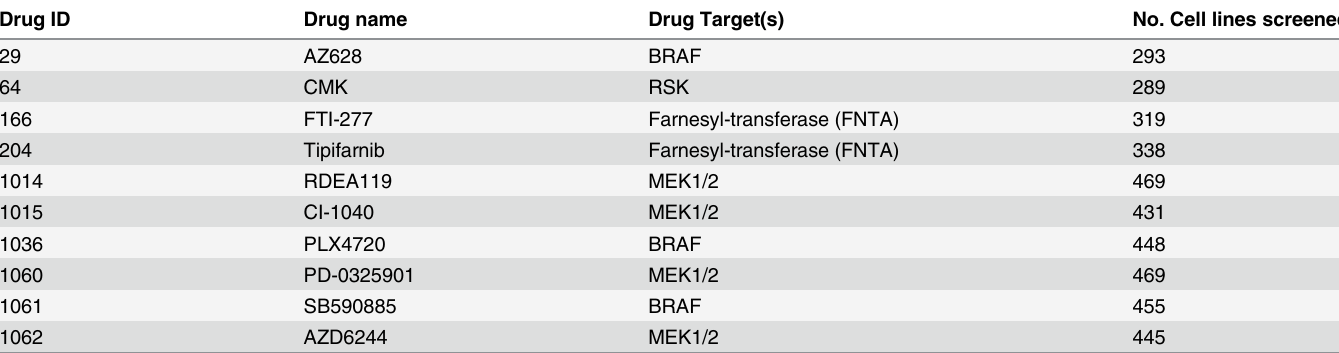
Table 2. 10 drugs which target genes in MAPK pathway.